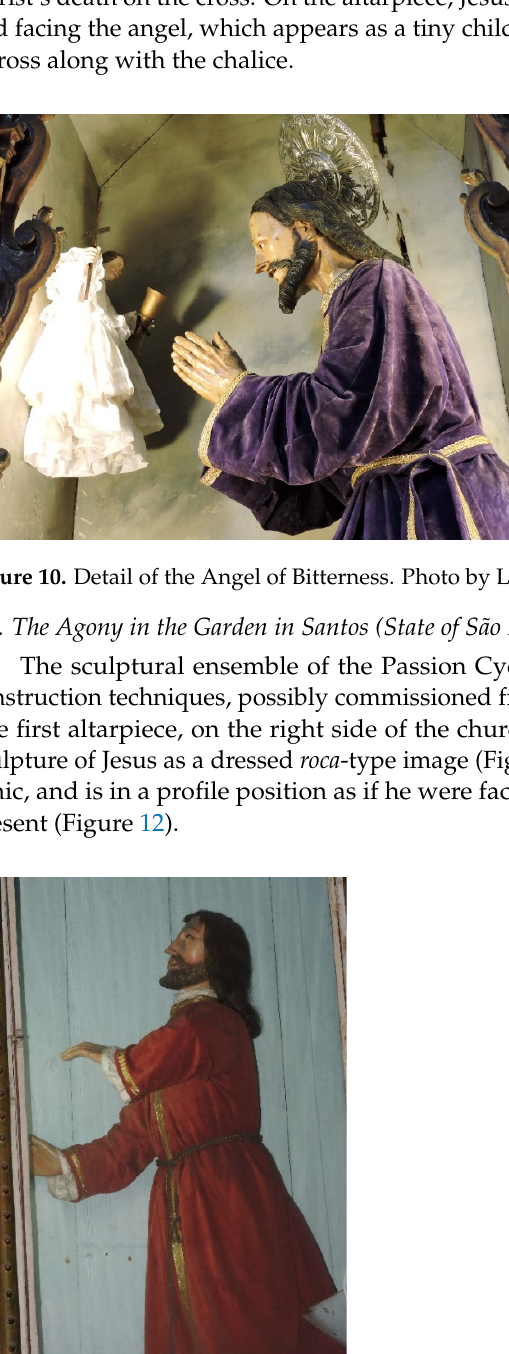
( b ) Figure 9. ( a ) Blocks of the legs. ( b ) Detail of the thighs fixed to the base. Photos by Lia Brusadin, 26 December 2016.